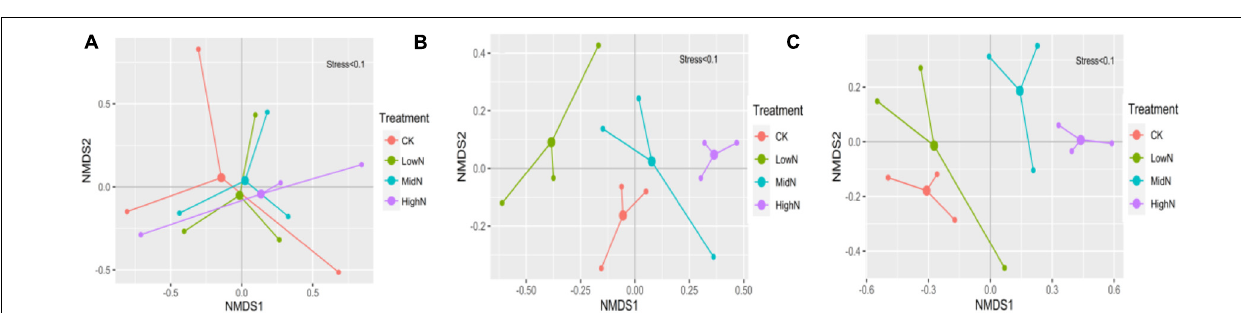
FIGURE 4 | Non-metric multidimensional scaling (NMDS) plot of species composition from 2015 to 2017 under different treatments. (A) 2015; (B) 2016; (C) 2017. 0 kgN ha − 1 yr − 1 (CK), 8 kgN ha − 1 yr − 1 (LowN), 40 kgN ha − 1 yr − 1 (MidN), and 72 kg N ha − 1 yr − 1